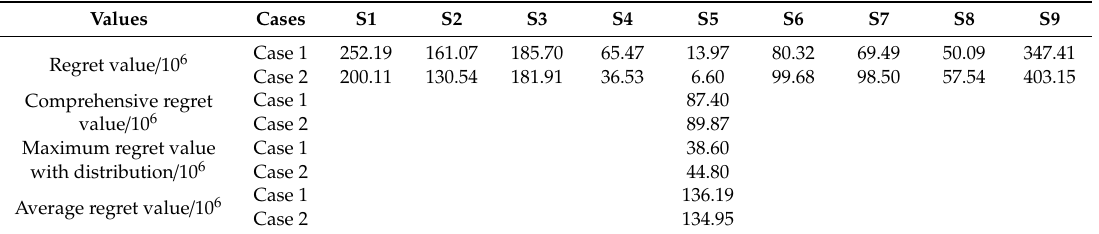
Table 9. Regret value under multiple scenarios with di ff erent planning